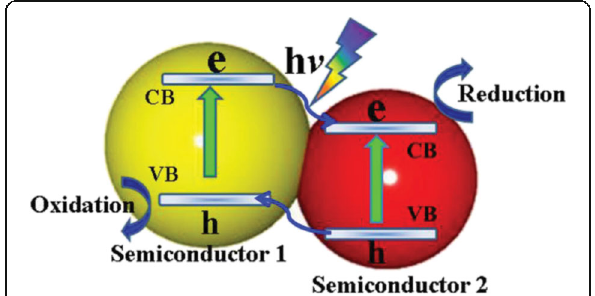
Fig. 2 The systematic representation of the type II heterojunction semiconductor. Reproduced with permission [25]. Copyright 2015